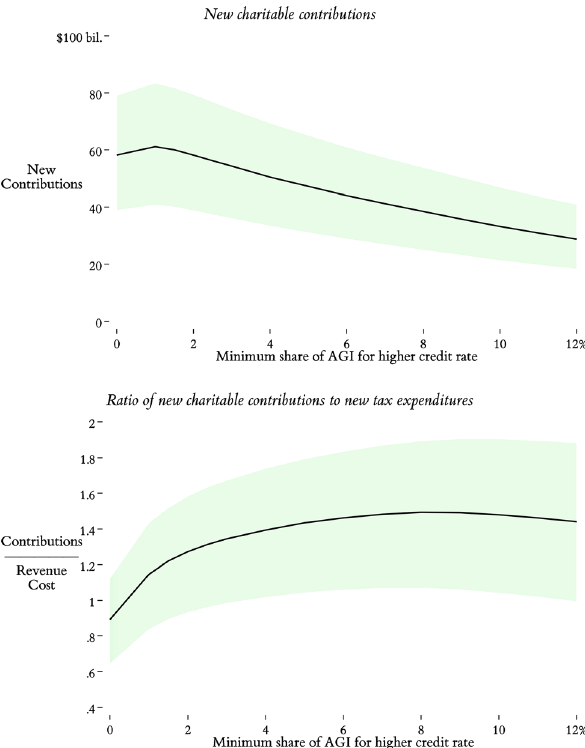
Figure 3: Outcomes of alternative AGI thresholds for higher credit rate. Notes: Black lines mark simulations under baseline assumption of taxpayer sensitivity to tax incentives. Green shading markstherangebetweenalternativehigh-andlow-sensitivityconditions.Simulationsassumea nonrefundable credit for charitable donations of 10% up to some share of AGI, and 37%